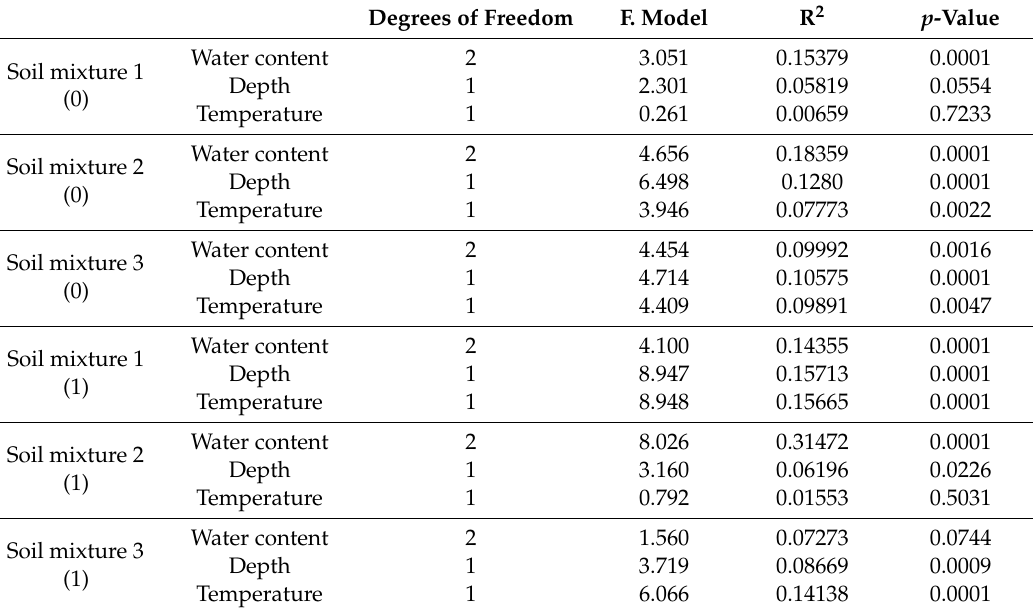
Table 3. PERMANOVA analysis of the PLFA values of the soil mixtures.